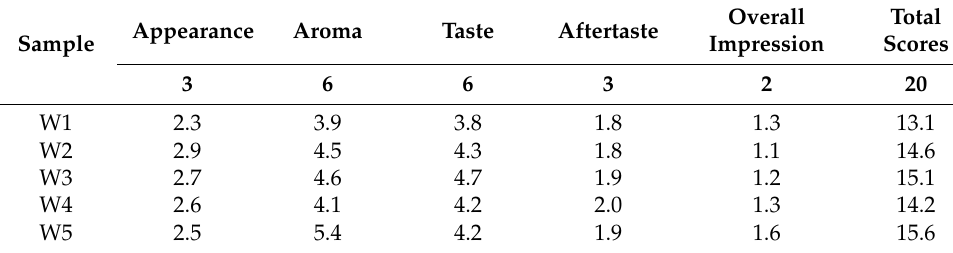
Table 7. Scores of sensory characteristics of black chokeberry wines by tasting panel. Appearance Aroma Taste Aftertaste Sample